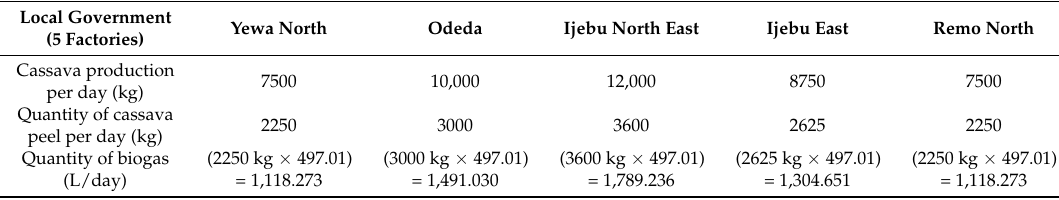
Table 2. Biogas production potential from cassava